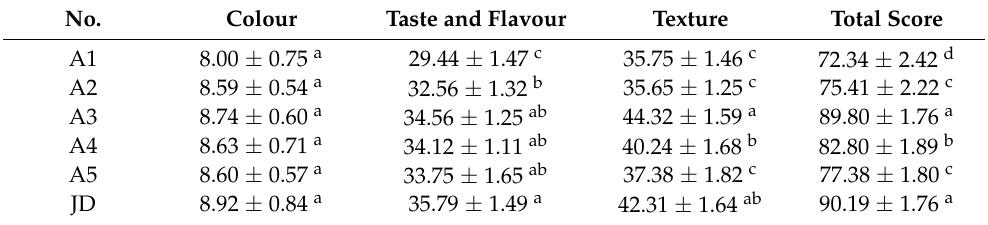
Table 3. Sensory evaluation of yogurts produced through fermentation using different ratios of L. delbrueckii subsp. bulgaricus IMAU20312 and S. thermophilus IMAU80809 in starter cultures com- pared with the commercial starter culture.